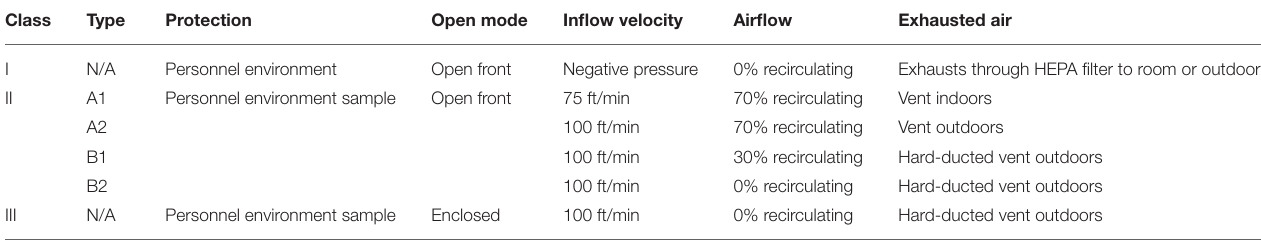
TABLE 1 | Classification of the biosafety